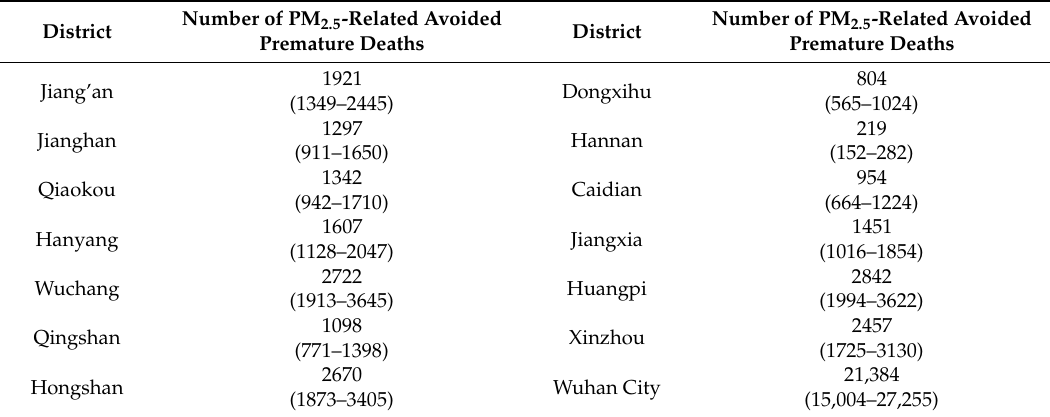
Table 2. Total number of PM 2.5 -related avoided premature deaths in Wuhan between 2013 and 2017 (95% confidence